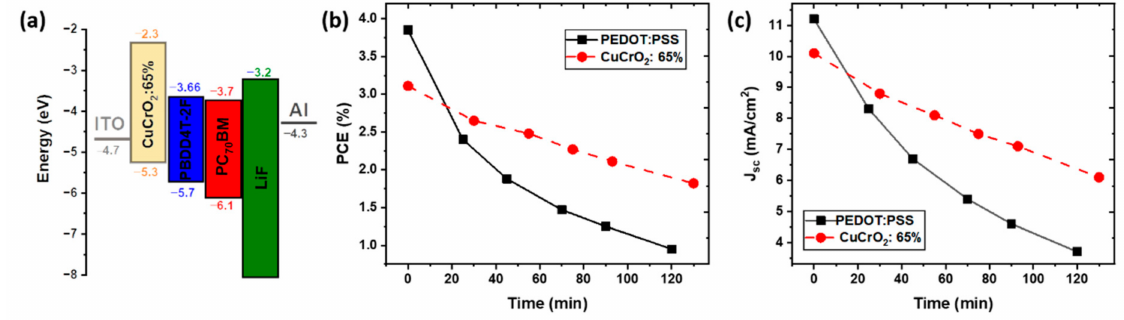
Figure 4. Band diagram of the CuCrO 2 :65% device and stability in atmospheric conditions. ( a ) Schematic energy diagram of the CuCrO 2 : 65% device. ( b ) PCE and ( c ) J sc as a function of the storage time (minutes) in atmospheric conditions at 23 ◦ C, 30% R.H. for OSC based on CuCrO 2 : 65% or